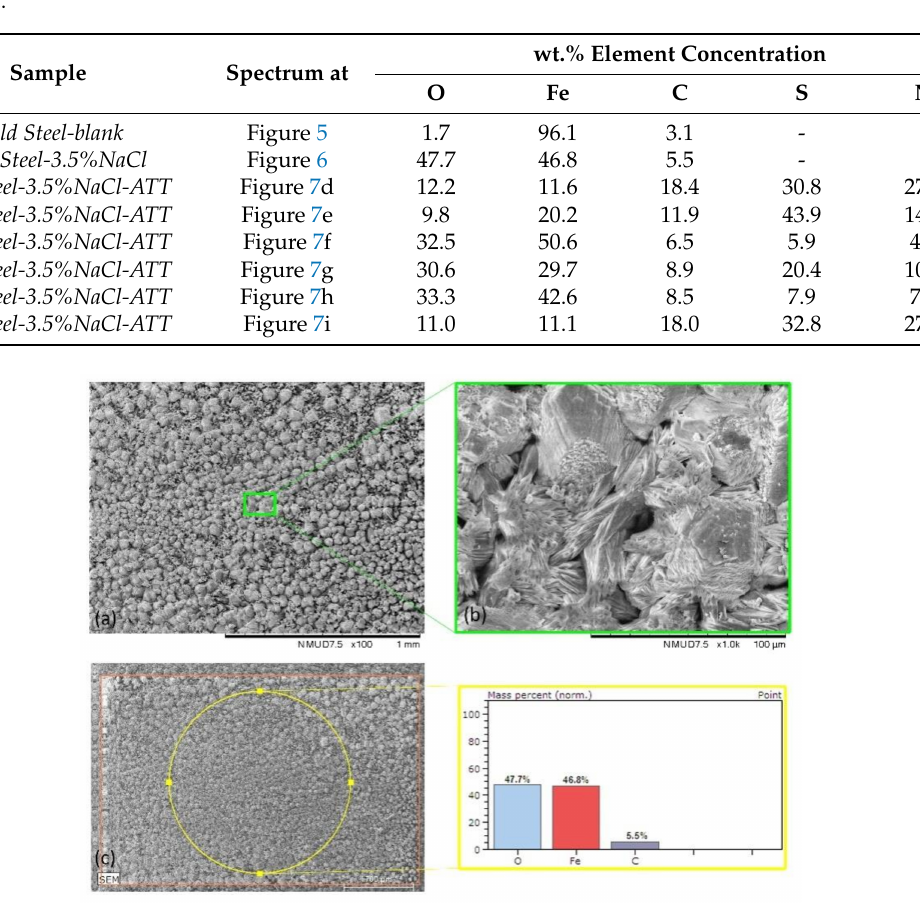
Figure 6. ( a , b ) SEM images and the corresponding ( c ) EDS analysis of mild steel immersed into 3.5 wt.% NaCl for 144 h (Mild